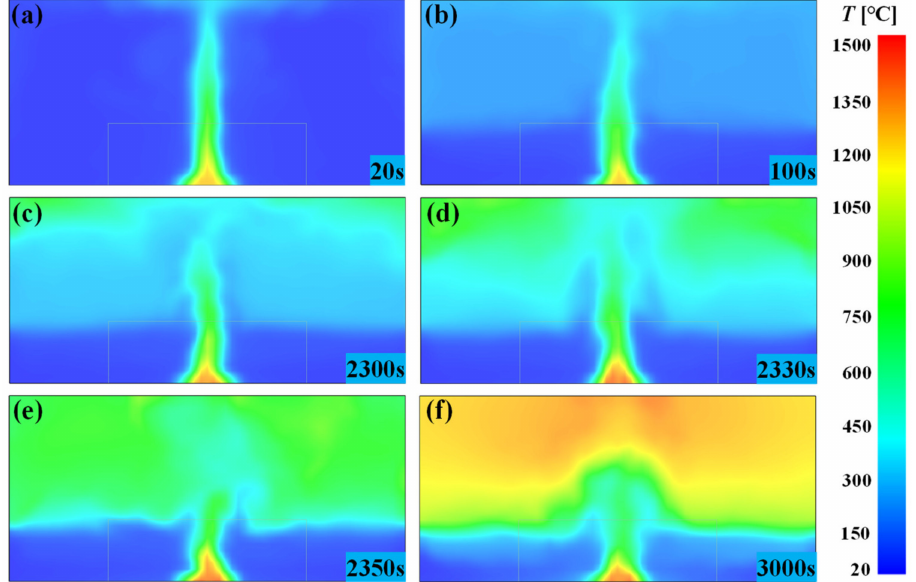
Figure 19. The evolution process of flashover fire in a large-space timber structure: ( a ) t = 20 s; ( b ) t = 100 s; ( c ) t = 2300 s; ( d ) t = 2330 s; ( e ) t = 2350 s; ( f ) t = 3000